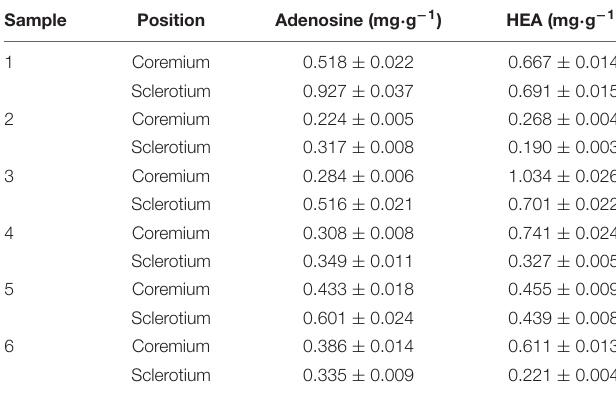
TABLE 3 | Contents of adenosine and HEA in different parts of wild cicada flower fruiting bodies.